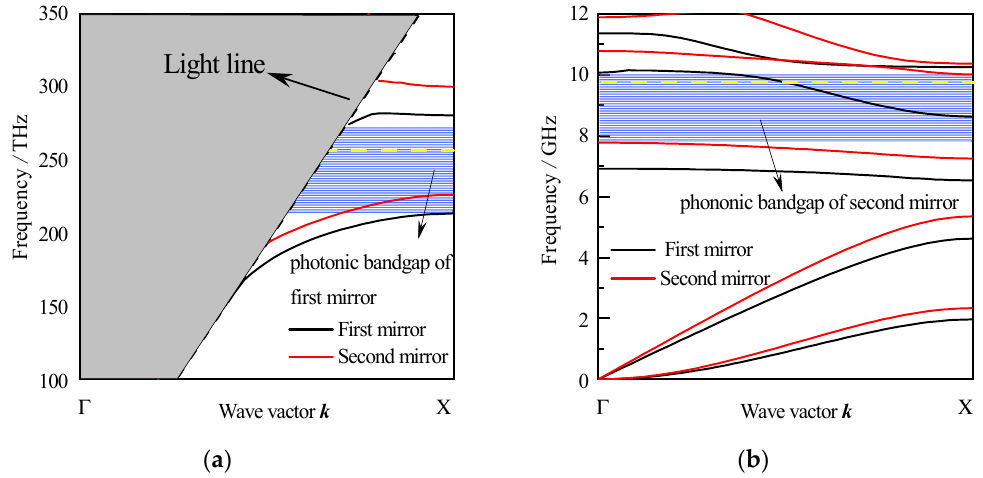
Figure 2. Band structures of the one-dimensional hetero-optomechanical crystal nanobeam: ( a ) the photonic band structures, where the blue region is the photonic bandgap of the first mirror; ( b ) the phononic band structures, where the blue region is the phononic bandgap of the second mirror. In both figures, the yellow dashed lines represent the frequencies corresponding to the optical and acoustic defect modes that open in the photonic and phononic bandgaps.